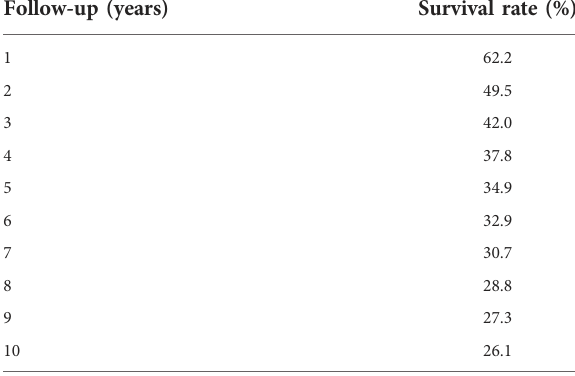
TABLE 1 Survival of 4,283 patients with ACC from the SEER database.